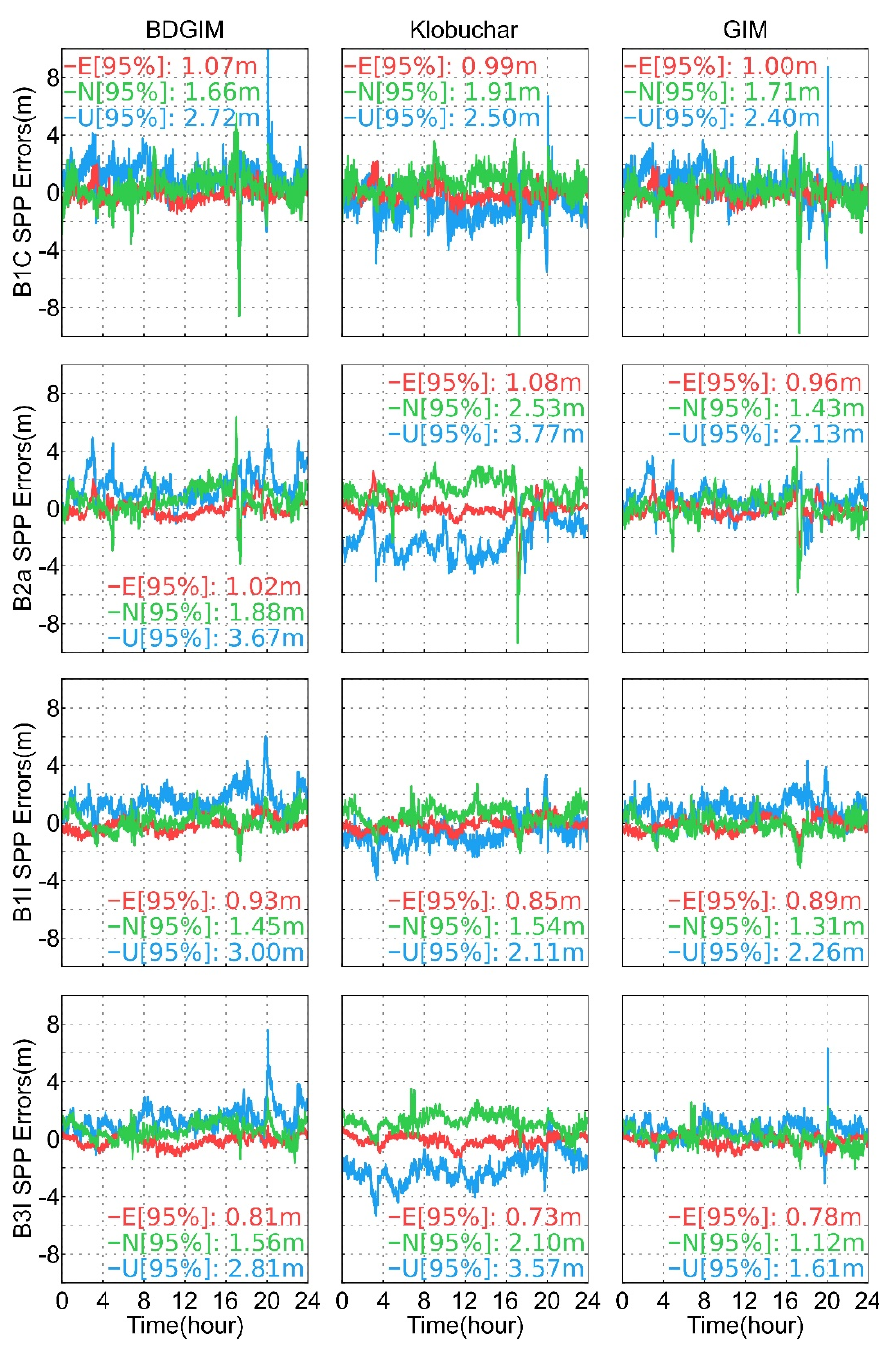
Figure 7. The time series of SPP errors at the station CLGY on January 25, 2020. The four rows represent the signals of B1C, B2a, B1I and B3I from top to bottom, and in each row the left, the middle and the right panels represent the BDGIM, the Klobuchar model and the GIM. In each panel, the time series and statistics corresponding to the directions of east (E), north (N) and up (U) are displayed in red, green and blue, respectively.